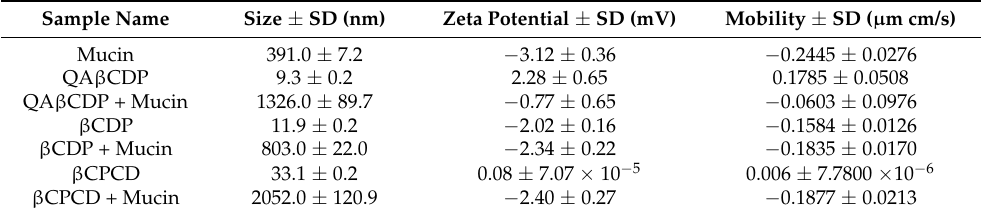
Table 3. Interaction of mucin with different cyclodextrin polymers measured by DLS and zeta potential (data are presented as means ± SD, n =